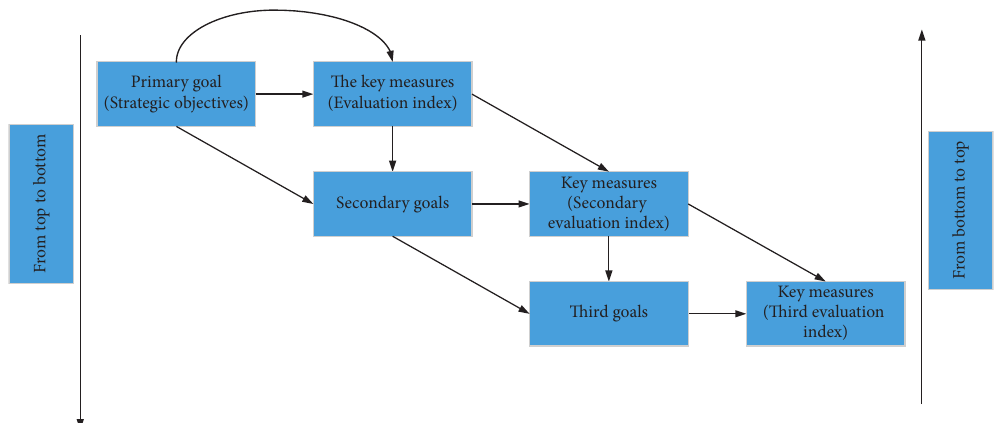
Figure 9: Index decomposition